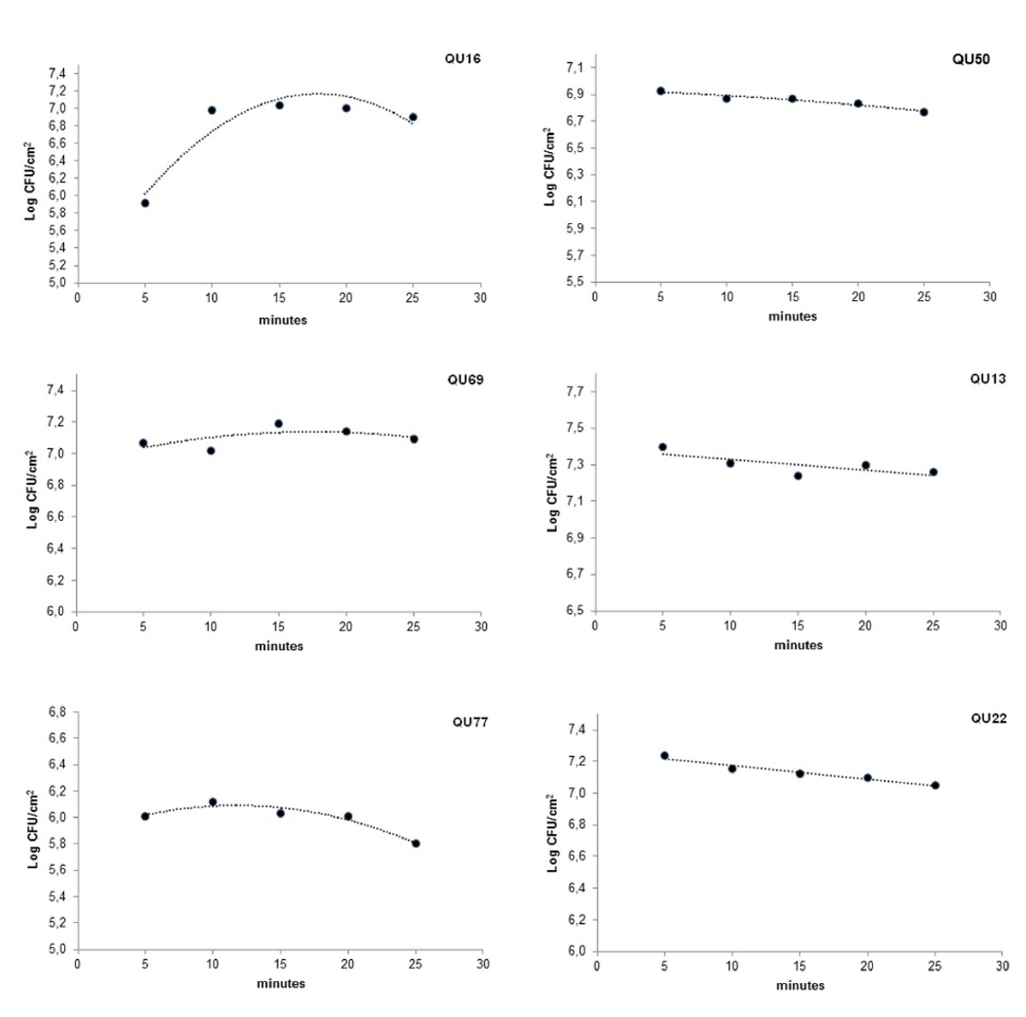
Figure 5. Yarrowia lipolytica isolates used in the assay with mild detergent (3 %): QU16, QU50, QU69, QU77, QU22, QU13 at 5, 10, 15, 20, 25